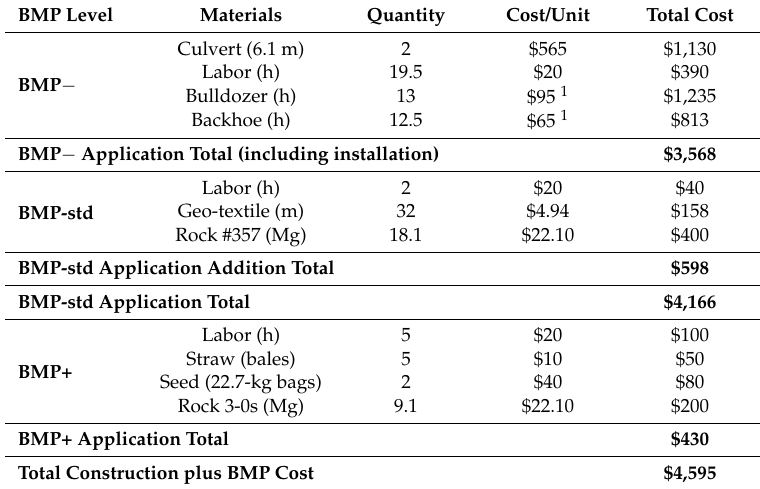
Table 4. Crossing and BMP construction materials and costs required for installation of a culvert on a 17-ha watershed.